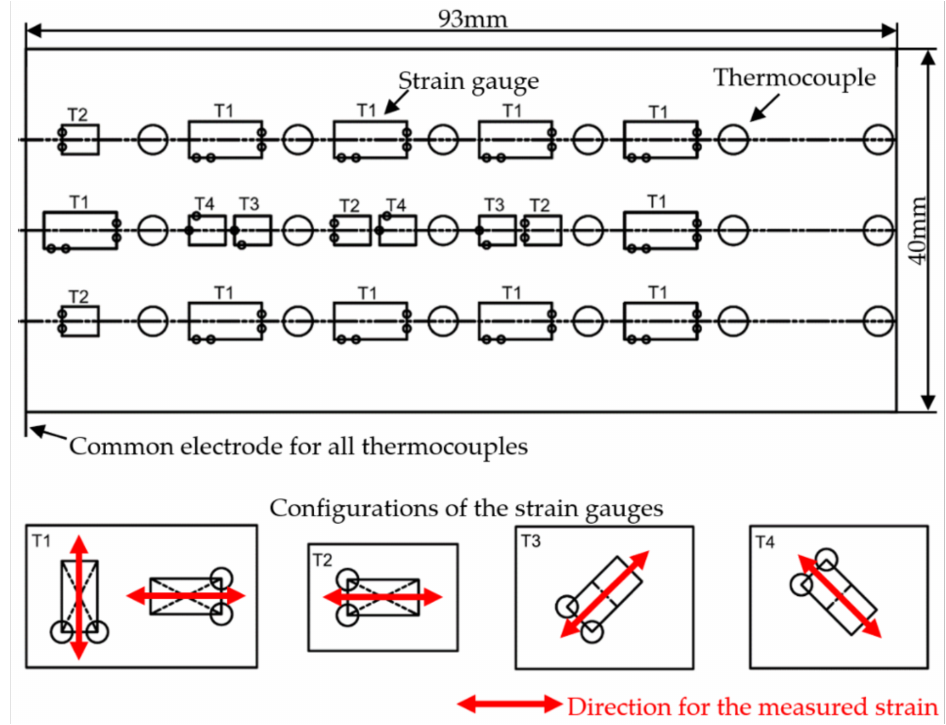
Figure 5. View of the flattened prototype sensing top foil to visualize the circumferential and axial distribution of the integrated thermocouples and strain gauges. Four configurations of the strain gauges were considered to allow multiaxial strain acquisition. However, in the current study, the authors only investigate the temperature and strain change based on the centrally axially located sensors to provide preliminary results and general thermomechanical characterization for the inspected bearing, as announced in Section 3.